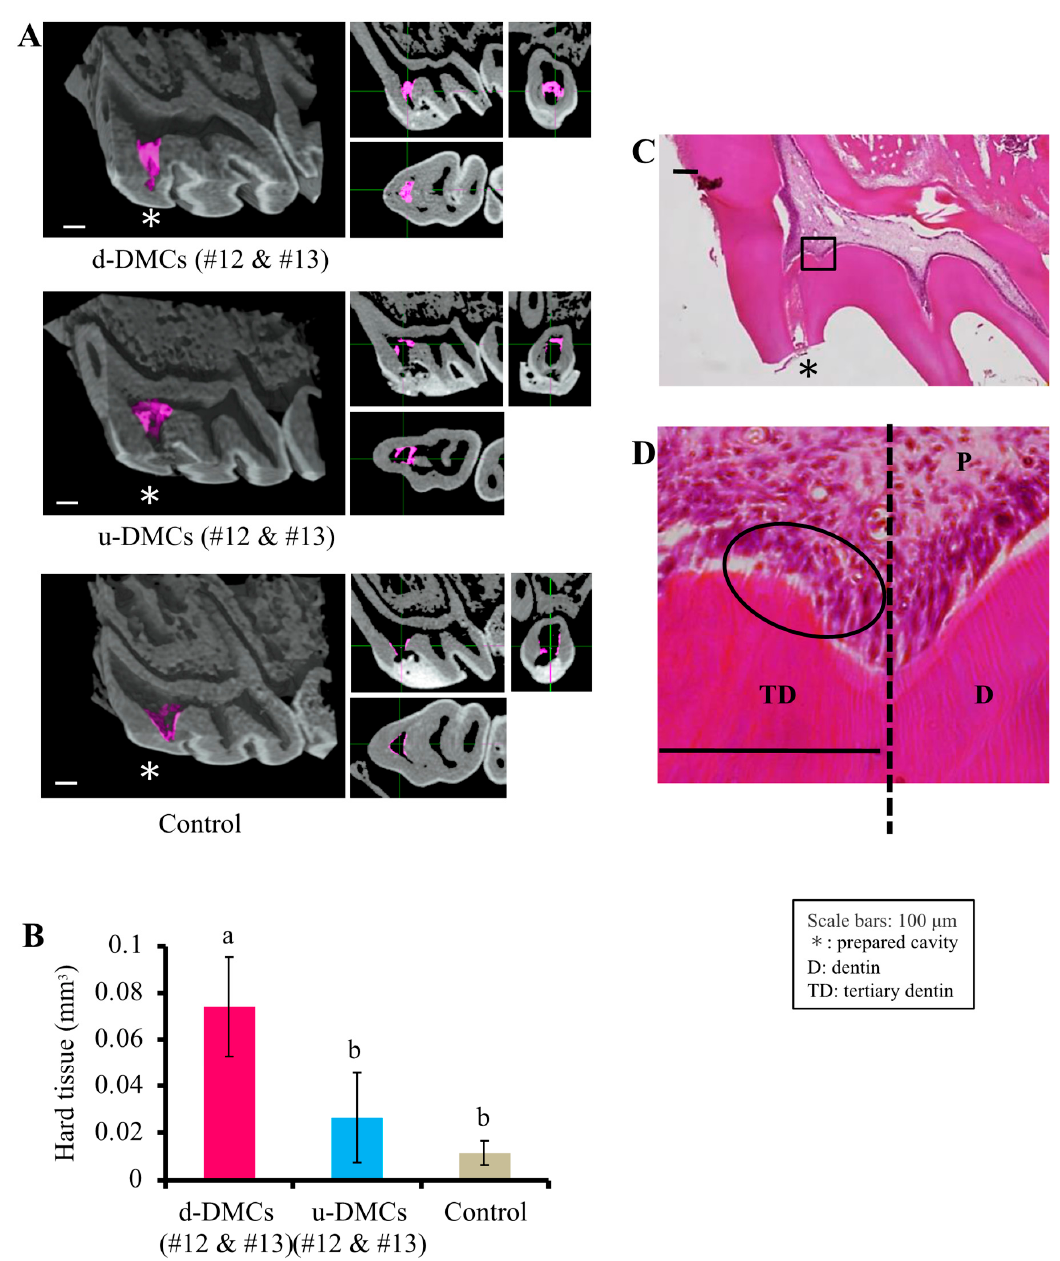
Figure 2. E ff ects of the fractions on tertiary dentinogenesis. ( A ) µ -CT images of tertiary dentin (pink area) induced using fractions #12 and #13 from d-DMCs or u-DMCs, or the control as pulp capping materials. ( B ) Quantification of the tertiary dentin volume ( n = 3 per group). ( C , D ) Panoramic and high-power H-E-stained images of tertiary dentin formation promoted by d-DMC fractions. An odontoblast-like cell layer and tubular-like structure were observed in the circled area in (D) (D = primary dentin, TD = tertiary dentin, and P = pulp). Images are representative of three independent experiments. Quantitative data are means ± s.e.m. Groups with similar lowercase letters (i.e., a and b) are not significantly different ( P > 0.05).